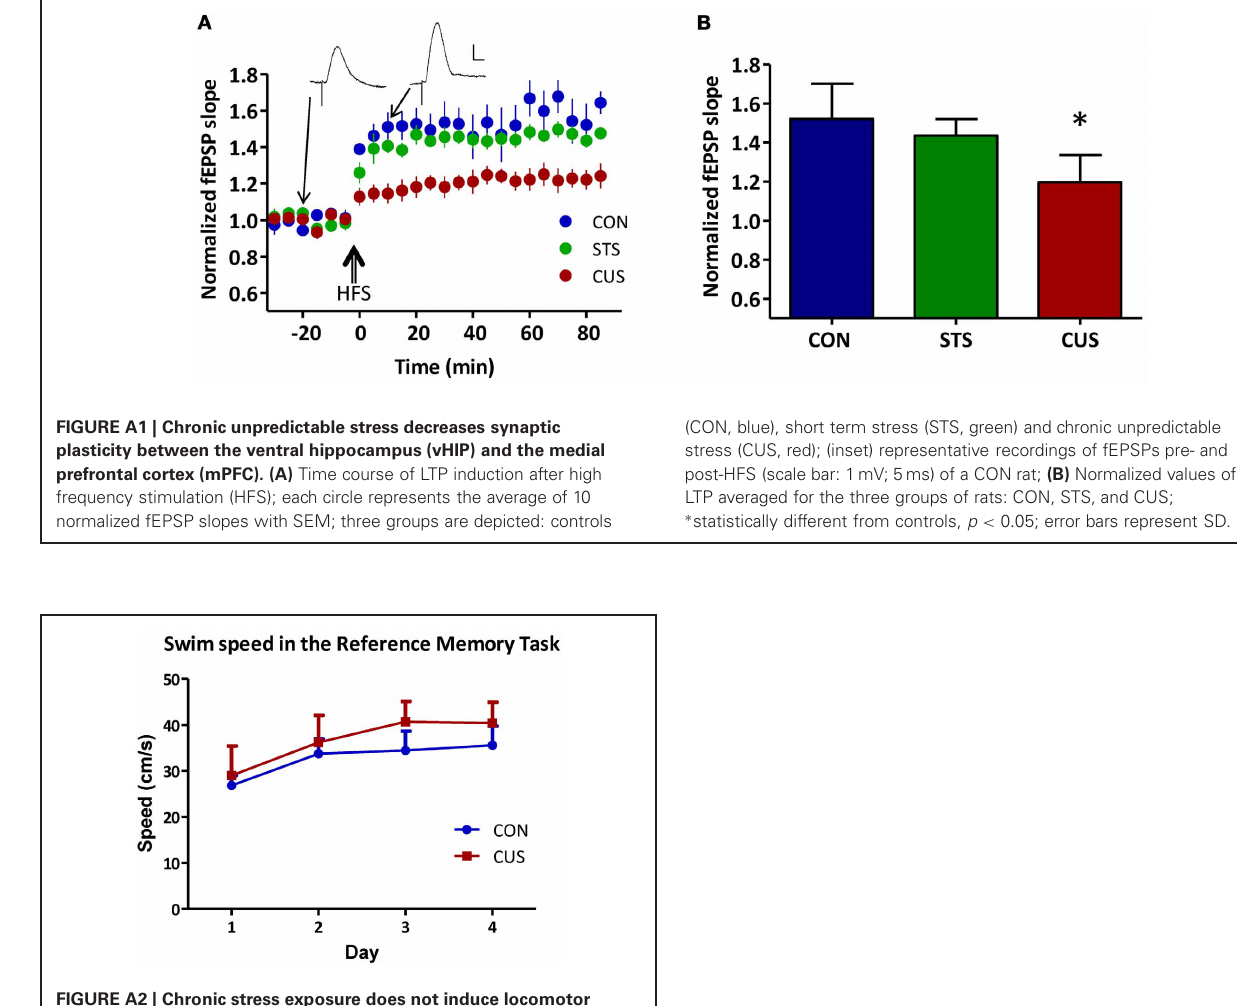
FIGURE A2 | Chronic stress exposure does not induce locomotor deficits. Average swimming speeds of CON (blue) and CUS (red) rats during the 4 days spatial reference memory task. No differences are observed between groups in each day ( p > 0 . 05); error bars represent